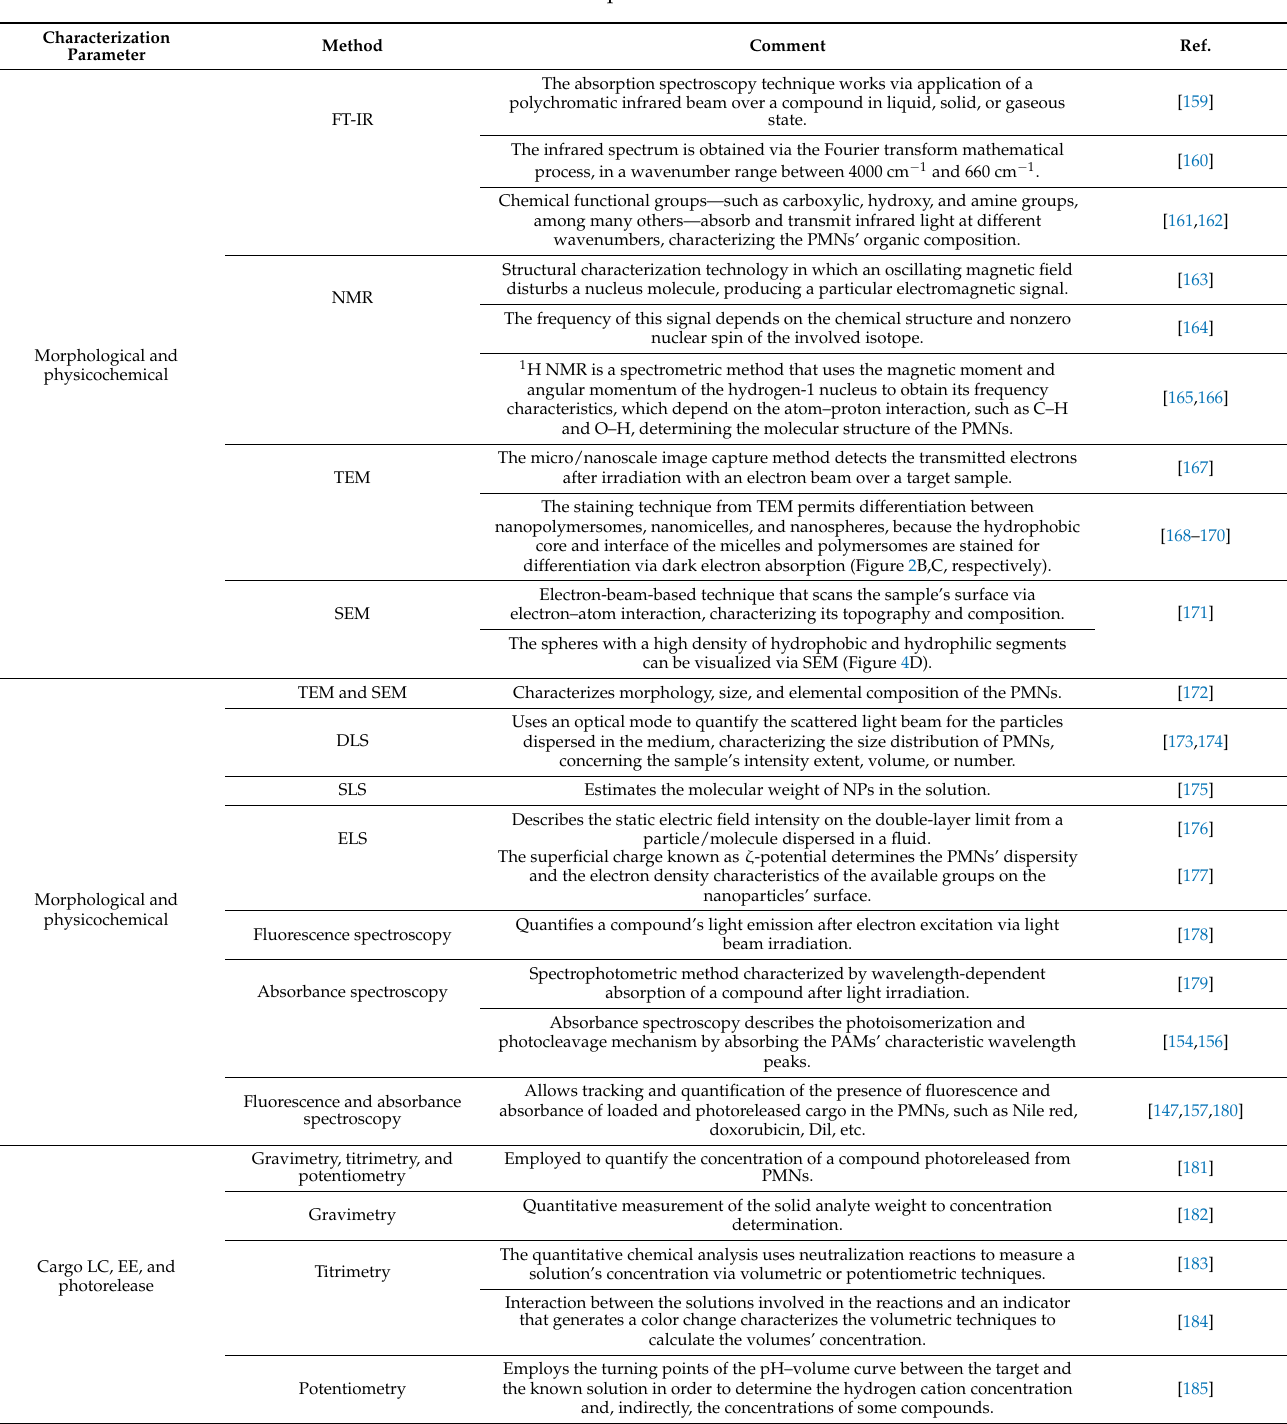
Table 2. Characterization of photosensitive